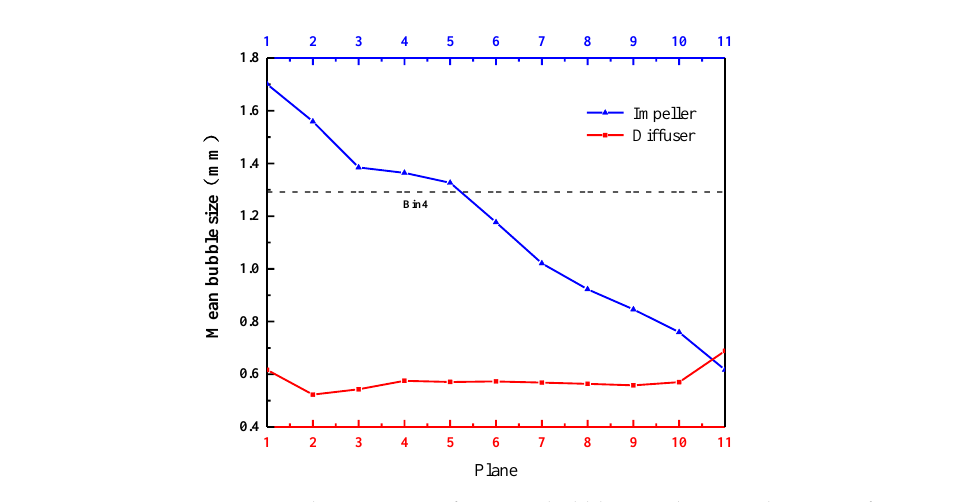
Figure 9. Change curve of average bubble size along axial section of pressurizing unit.